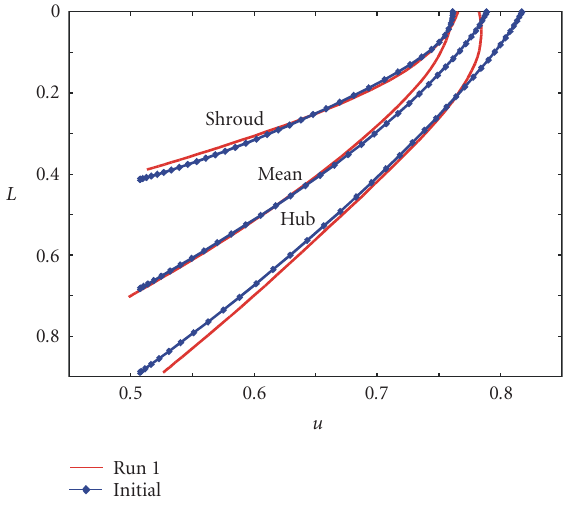
Figure 8: Conformal mapping representation of the runner blade for the initial design and the first optimization run.